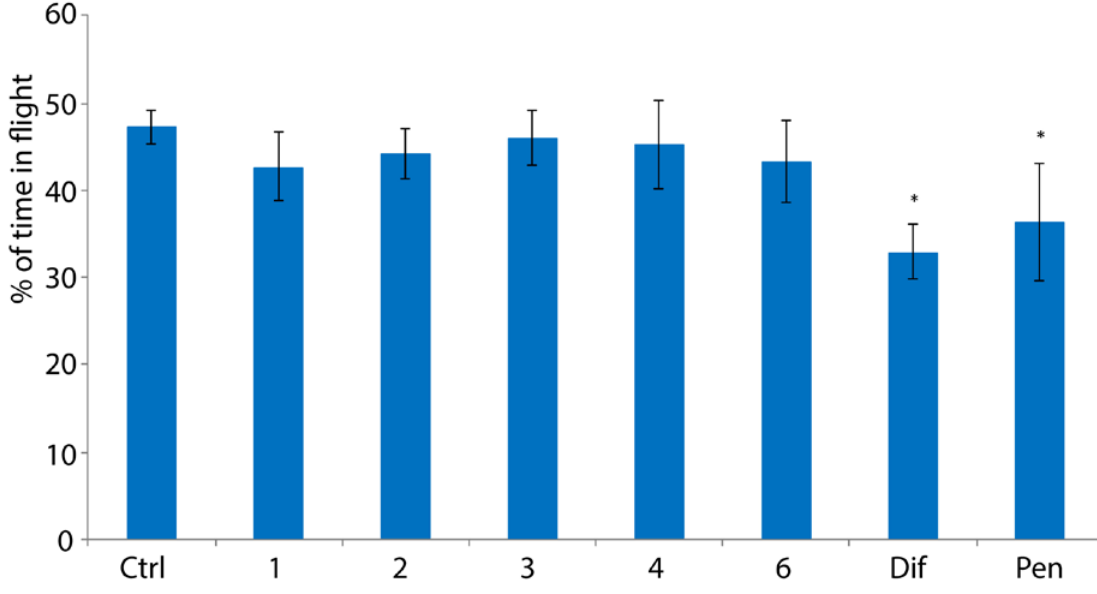
Figure 4. The effect of studied peroxides 1 – 4 , 6 and commercial fungicides (difenoconazole, penconazole) on the ability of bumblebees to fly after consuming sugar syrup with the